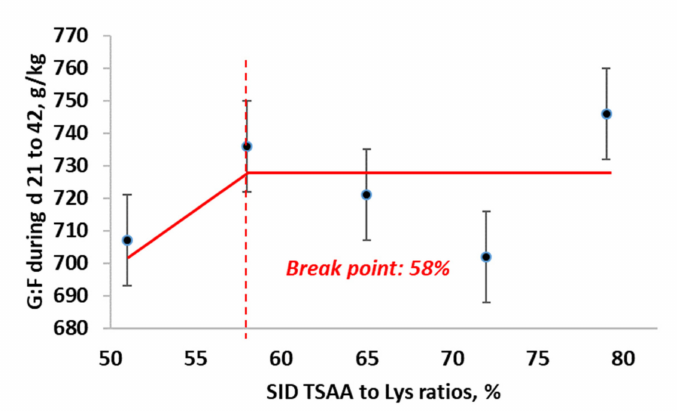
Figure 6. Broken-line linear ascending model for estimation of optimal SID TSAA to Lys ratio in nursery pigs under ABF for gain to feed from d 21 to